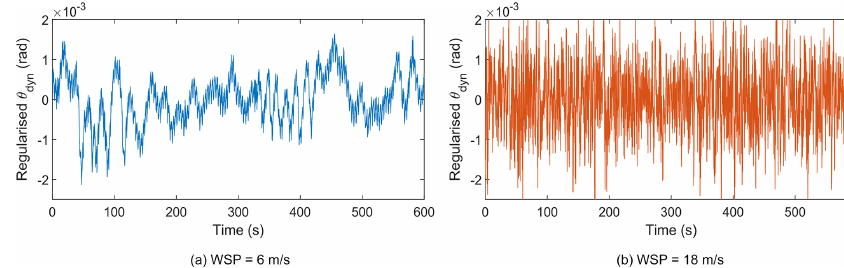
Figure 9. Regularised θ dyn for two mean wind speeds.